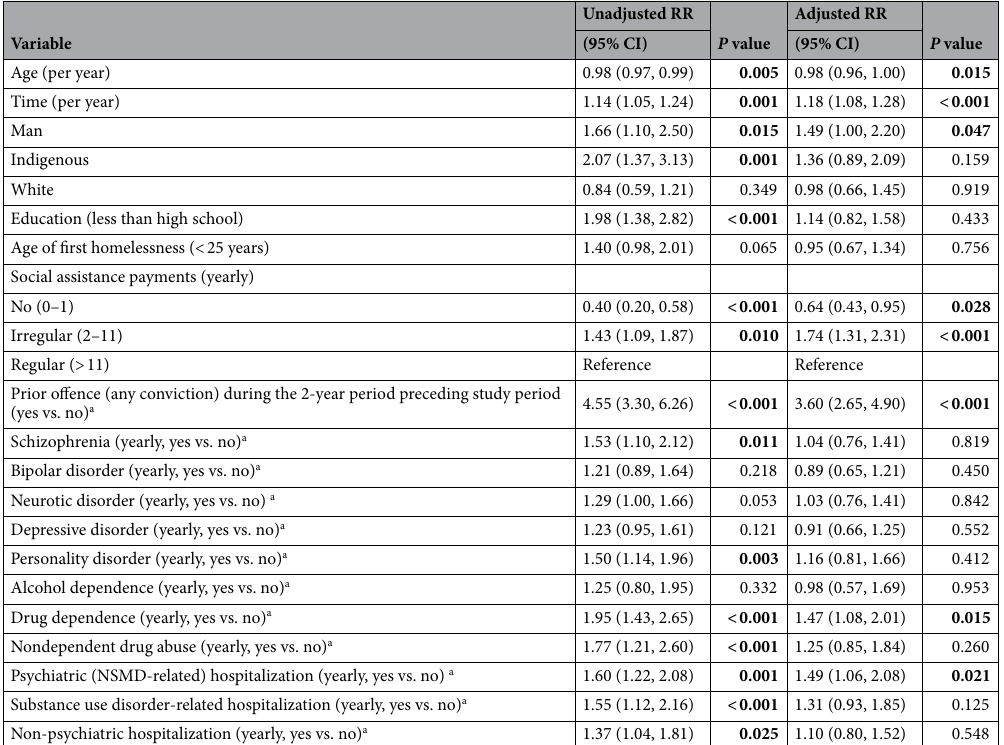
Table 3. GEE negative binomial regression analysis to identify risk and protective factors associated with the number of convicted offences (measured annually) among Vancouver At Home participants during the five years preceding study baseline (n = 425). a The reference group is